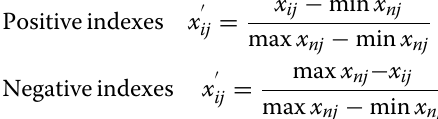
Algorithm 1 Evaluation index objective weight determination method with entropy theory.